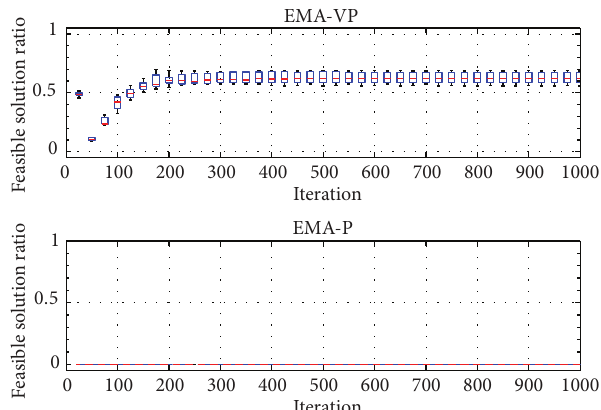
Figure 9: Ratio of feasible solutions for EMA-VP and EMA-P for RC